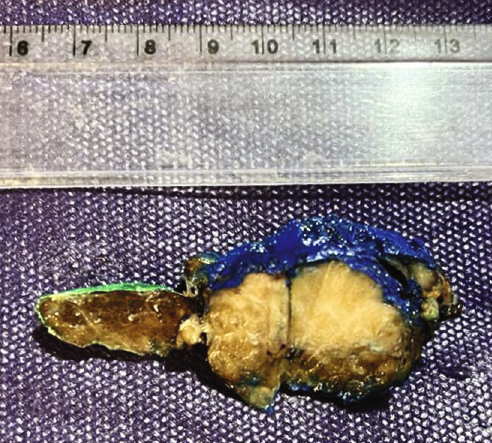
Figure 2: Chest X-ray of our patient on the day that she presented with dyspnea and chest pain.